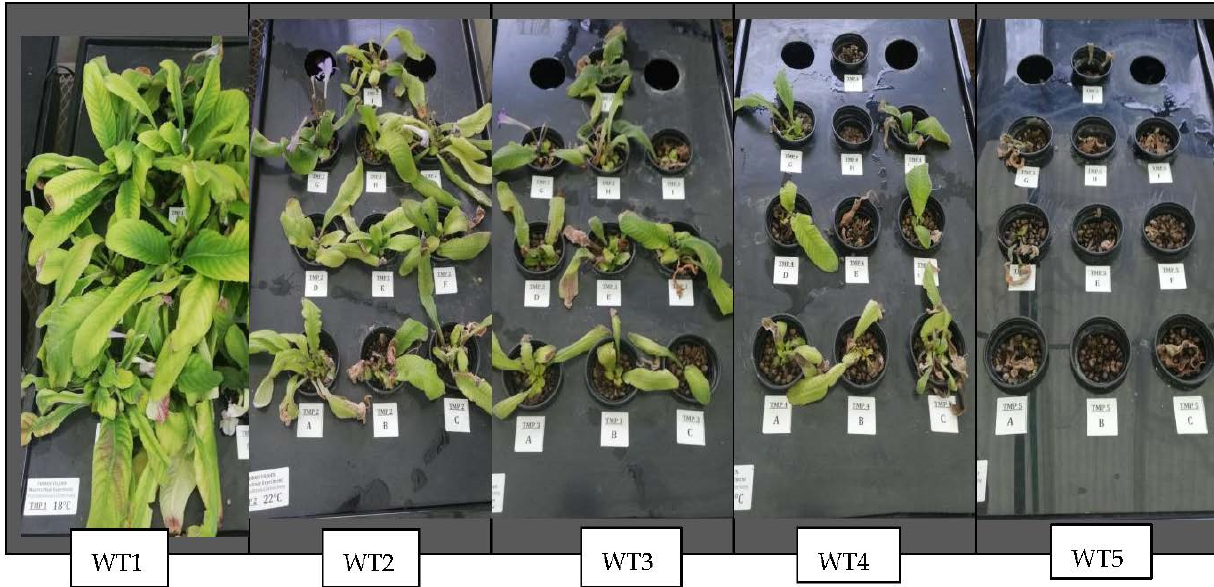
Figure 4. The visible effect of the escalating hydroponic root zone temperatures on the vegetative aerial parts of S . formosus evident through simple observation over the experimental period with a directly proportional reduction in leaf numbers and lengths at increasingly higher temperatures (Photos: C. Viljoen).